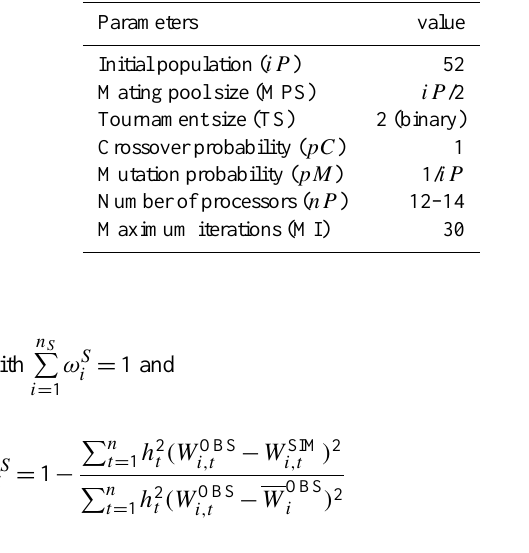
Table 4. Summary of parameter settings for multi-objective opti- mization in master-slave parallelization